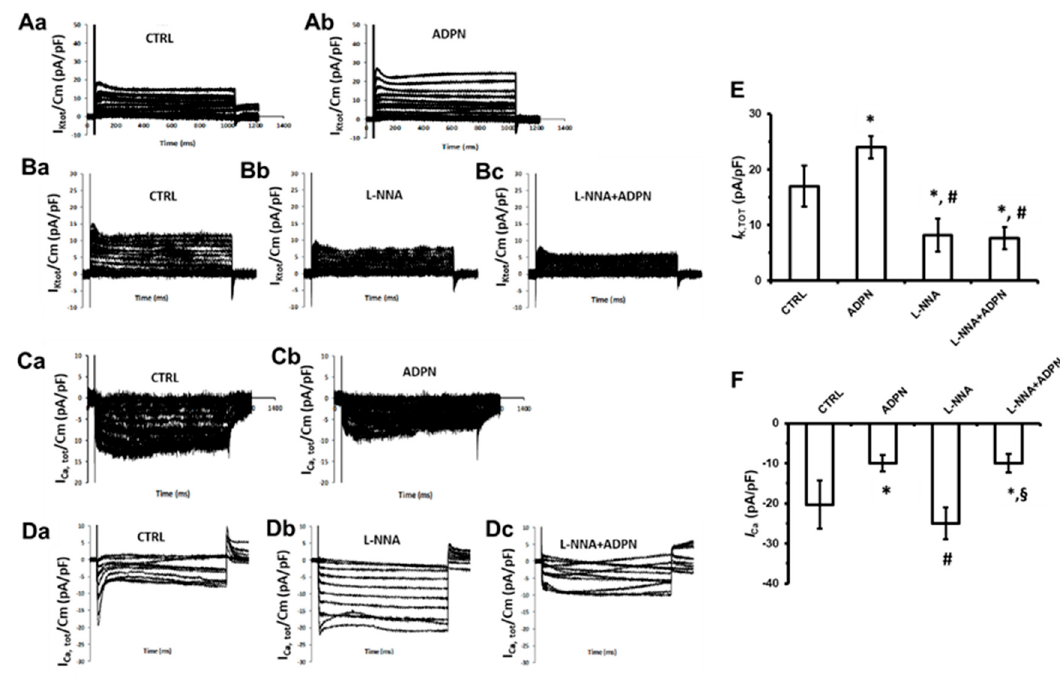
Figure 5. E ff ects of ADPN on the ion currents in a single SMC in the presence of L-NNA. ( Aa , Ab ) Typical tracing of total outward K + current recorded in a single control cell ( Aa ) and after ADPN addition ( Ab ). ( Ba–Bc ) Typical tracing of total outward K + current recorded in a single control cell ( Ba ), in L-NNA ( Bb ), and after ADPN addition in the presence of L-NNA ( Bc ). ( Ca , Cb ) Typical tracing of total inward Ca 2 + current recorded in a single control cell ( Ca ) and after ADPN addition ( Cb ). ( Da–Dc ) Typical tracing of total inward Ca 2 + current recorded in a single control cell ( Da ), in L-NNA ( Db ), and after ADPN addition in the presence of L-NNA ( Dc ). All current values are normalized to cell capacitance. ( E ) Bar charts representing the e ff ects of ADPN, L-NNA, and L-NNA + ADPN on the total K + current outflow. ( F ) Bar charts representing the e ff ects of ADPN, L-NNA, and L-NNA + ADPN on the total Ca 2 + current inflow. Bar charts are related to the current amplitude evoked by the + 50 mV step pulse, measured at the end of the stimulus for K + current and at the peak amplitude for Ca 2 + currents (Ip, peak current). Data evaluated in control condition (CTRL), 15 min after adiponectin addition to the bath solution (ADPN) and after adding adiponectin in the presence of L-NNA (L-NNA + ADPN). ( E , F ) One-way ANOVA with Bonferroni’s post hoc test was used for multiple comparisons. * , p < 0.05 vs. control; # , p < 0.05 vs. ADPN; § , p < 0.05 vs. L-NNA. Values are means ± SD. Current mean values are listed in Table 1.